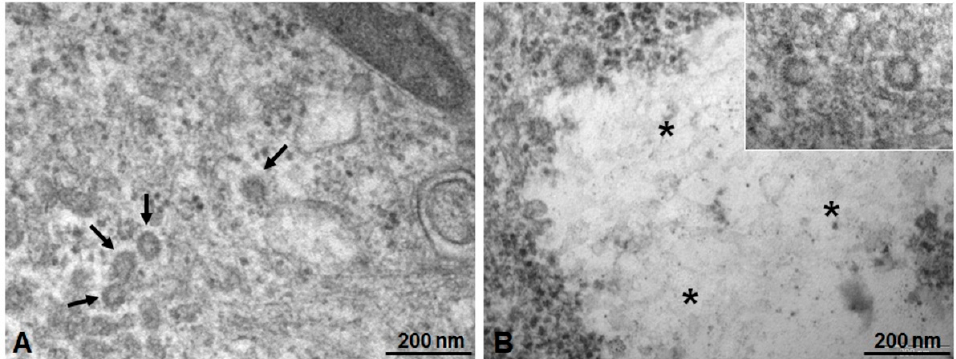
Figure 8. Electron micrographs (TEM) of Caco-2 cells treated with NPs and observed at the transmission electron microscope. ( A ) Cell culture with unloaded NPs, detectable as small rounded structures (about 100 nm sized) concentrated in cytoplasmic areas. Scale bar: 200 nm. ( B ) Caco-2 cell treated with ICG-loaded NPs. Rounded structures are distributed in cytoplasm (inset) and near to large light inclusion (asterisks). Scale bar: 200 nm.